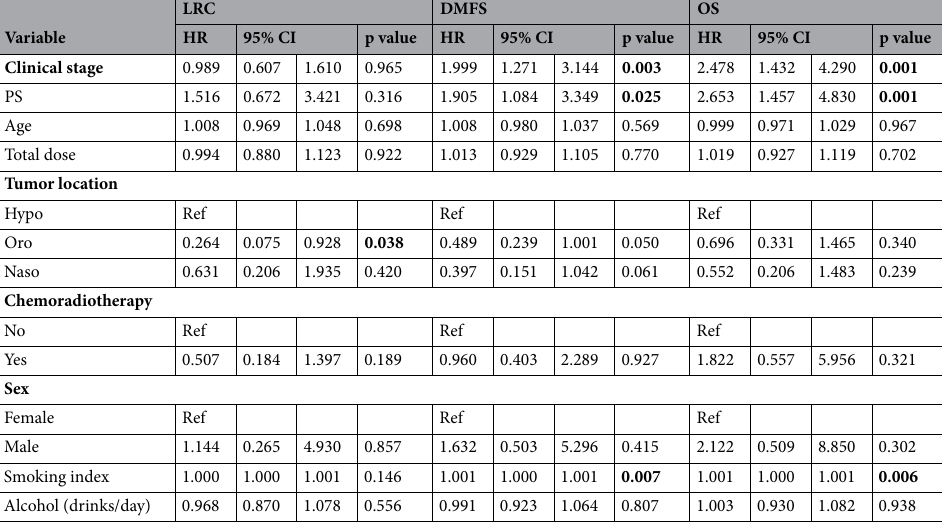
Table 2. Univariate analyses of clinical variables. PS performance status, LRC locoregional control, DMFS distant metastasis-free survival, OS overall survival. Significant values are in